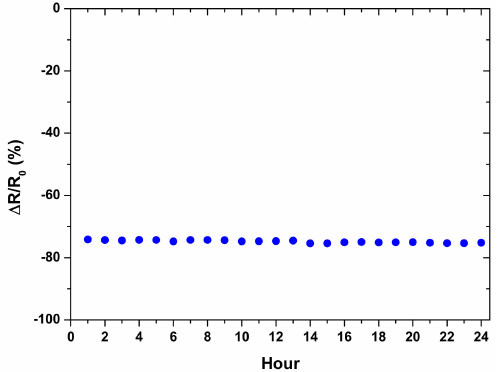
Figure 25. Sensor stability testing under constant loading for 24 h.